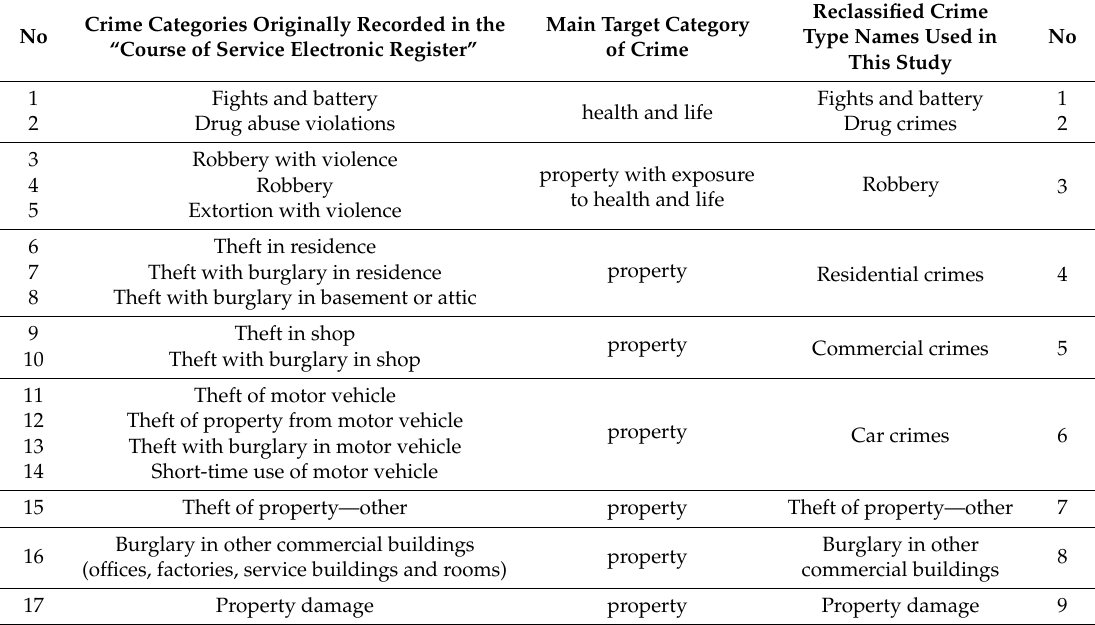
Table 1. Crime categories according to the “Course of Service Electronic Register” and reclassified crime types used in this study.